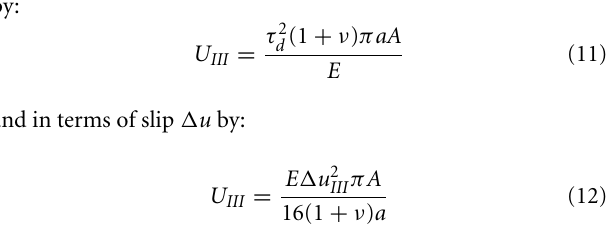
[Equation (6)], the seismic moment is shear modulus [N m − 2 ]